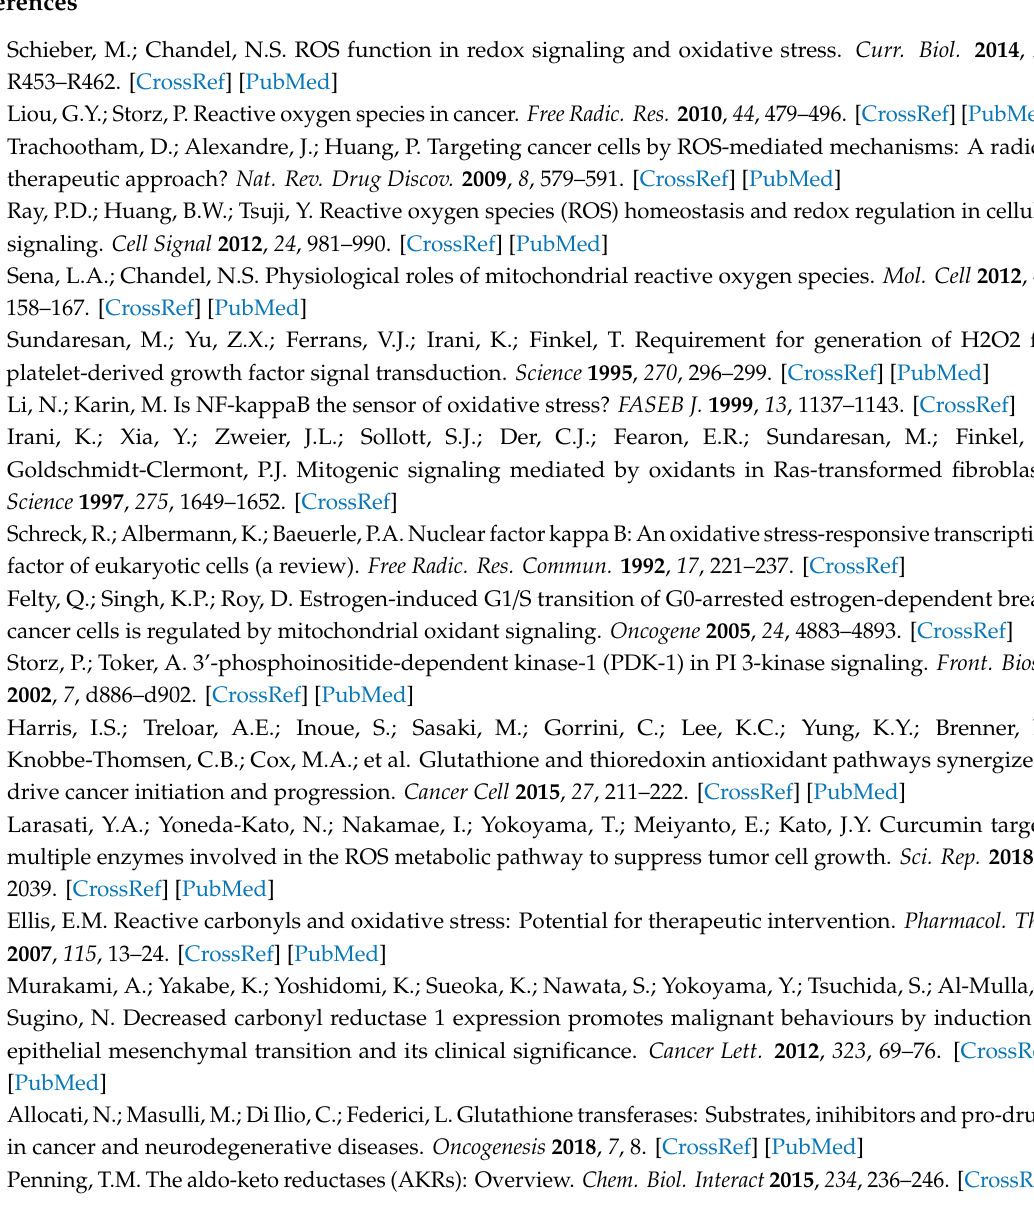
Figure S3: Spectra of Curcuminoids, Figure S4: Predicted binding sites for curcumin or curcumin derivatives on ROS metabolic enzymes, Spectra of Curcuminoids, Table S1: Summary of measurement variables of selected curcumin